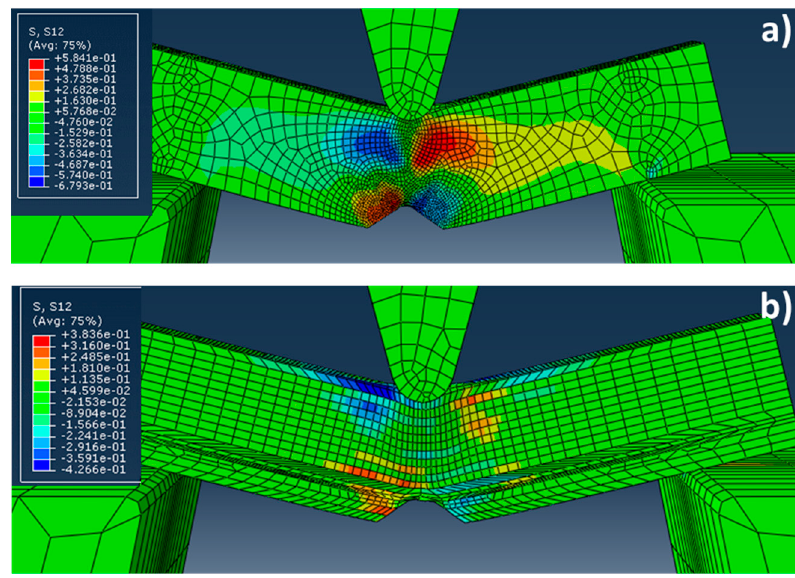
Figure 8. Lateral view (XY-plane) of the distribution of τ 12 shear stresses during the Charpy test for: ( a ) the single crystal case; and ( b ) the arrester configuration.